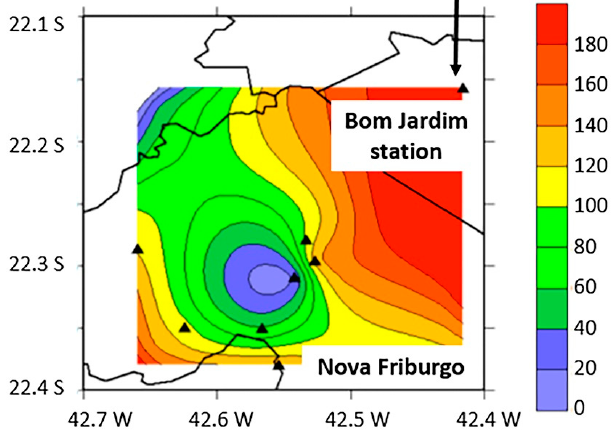
Figure 4. Interpolation of rainfall stations in the Rio Grande Basin for the rain observed on 11 January 2011 (mm/24 h). Source: Reprinted/adapted with permission from Ref. [24]. 2020. Barcellos and Cataldi.